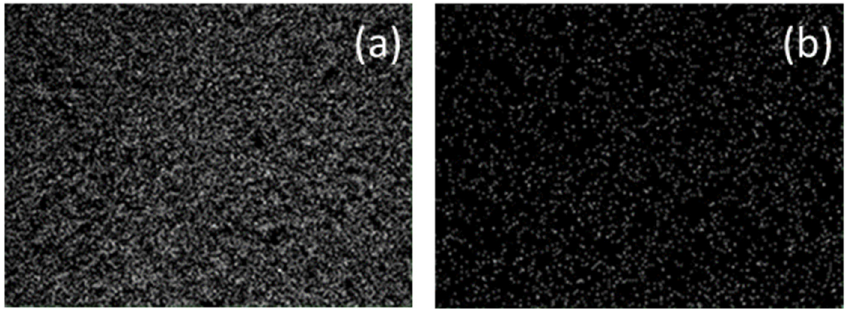
Figure 5. SEM analysis of ZnAl-SO 4 LDH after adsorption. The white colored areas refer to Al(III) and Cr(III) in panels ( a , b ), respectively.